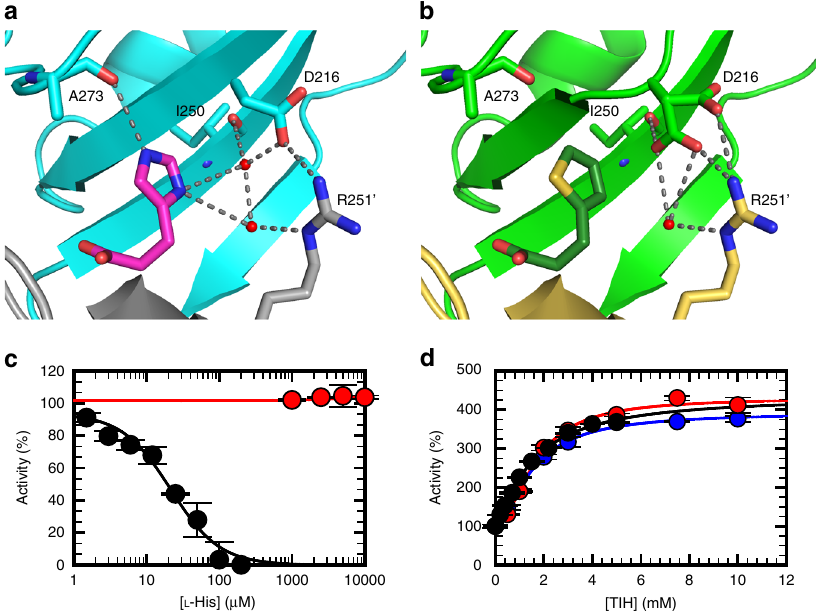
Fig. 6 Differential conformations and kinetics of wild-type and D216 ATP-PRT in the presence of L -His or TIH. Cartoon representation highlighting the H-bonds surrounding L -His a and TIH b in their respective crystal structures. The D216 side chain in the TIH-bound ATP-PRT structure could be fi tted in two conformations with 0.35 and 0.65 occupancy. Steady-state kinetics of ATP-PRT inhibition by L -His c , and activation by TIH d . WT ( black circles) , D216 V ( red circles ) and D216 V + 2 mM L -His ( blue circles ), error bars indicate the s.d., n = 3. Circles are experimental measurements and lines are the best fi t to Eq. 2 (Methods section) for inhibition by L -His and Eq. 4 (Methods section) for activation by TIH. Data for D216 V inhibition by L -His were fi t to a linear regression. For WT, an IC 50 for L -His of 22 ± 4 μ M and an AC 50 for TIH of 1.5 ± 0.2 mM were obtained. For D216 V, an AC 50 for TIH of 1.7 ± 0.1 mM was obtained, which did not change in the presence of 2 mM L -His, with an AC 50 of 1.5 ± 0.1 mM. L -His (up to 10 mM) did not change D216 V activity and therefore an IC 50 could not be